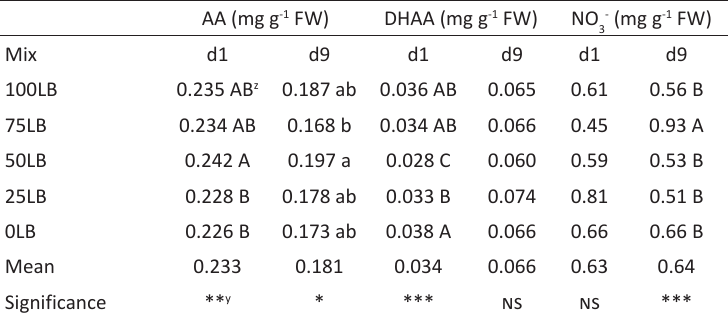
Table 4. Ascorbic acid (AA), dehydroascorbic acid (DHAA) and nitrate (NO 3- ) contents in the fresh-cut product (100% ‘Lollo Bionda’ lettuce [ 100LB ] , 75% LB [ 75LB ] ,